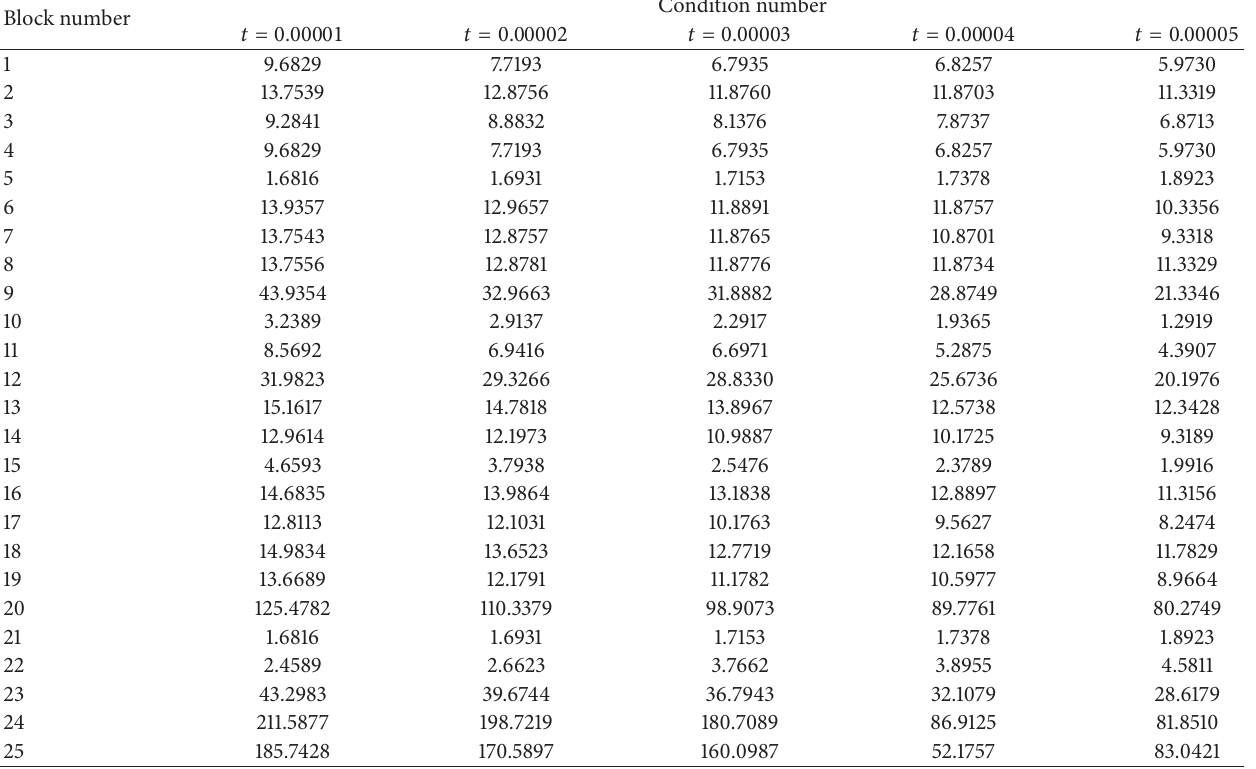
Table 1: Condition number of each image block at different